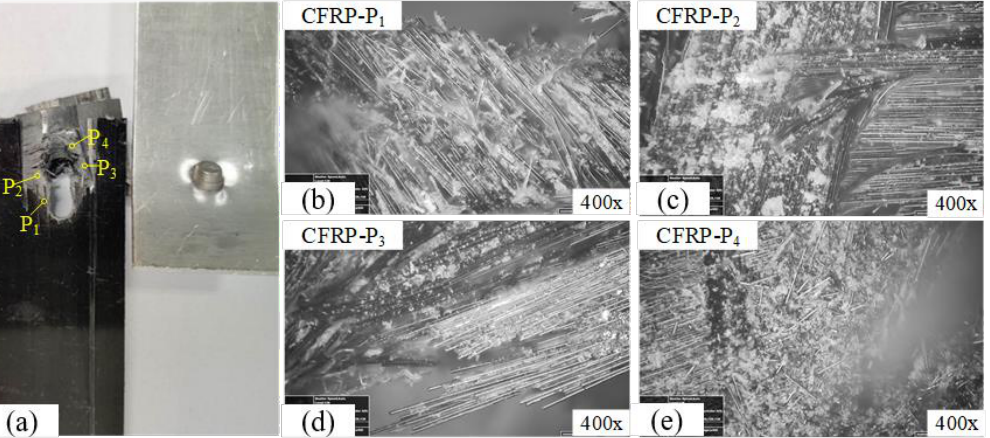
Figure 15. The specimen fracture morphology of the 44° TRM: ( a ) Observation diagram; ( b ) CFRP P 1 area; ( c ) CFRP P 2 area; ( d ) CFRP P 3 area; ( e ) CFRP P 4 area. area; ( c ) CFRP P 2 area; ( d ) CFRP P 3 area; ( e ) CFRP P 4 area.